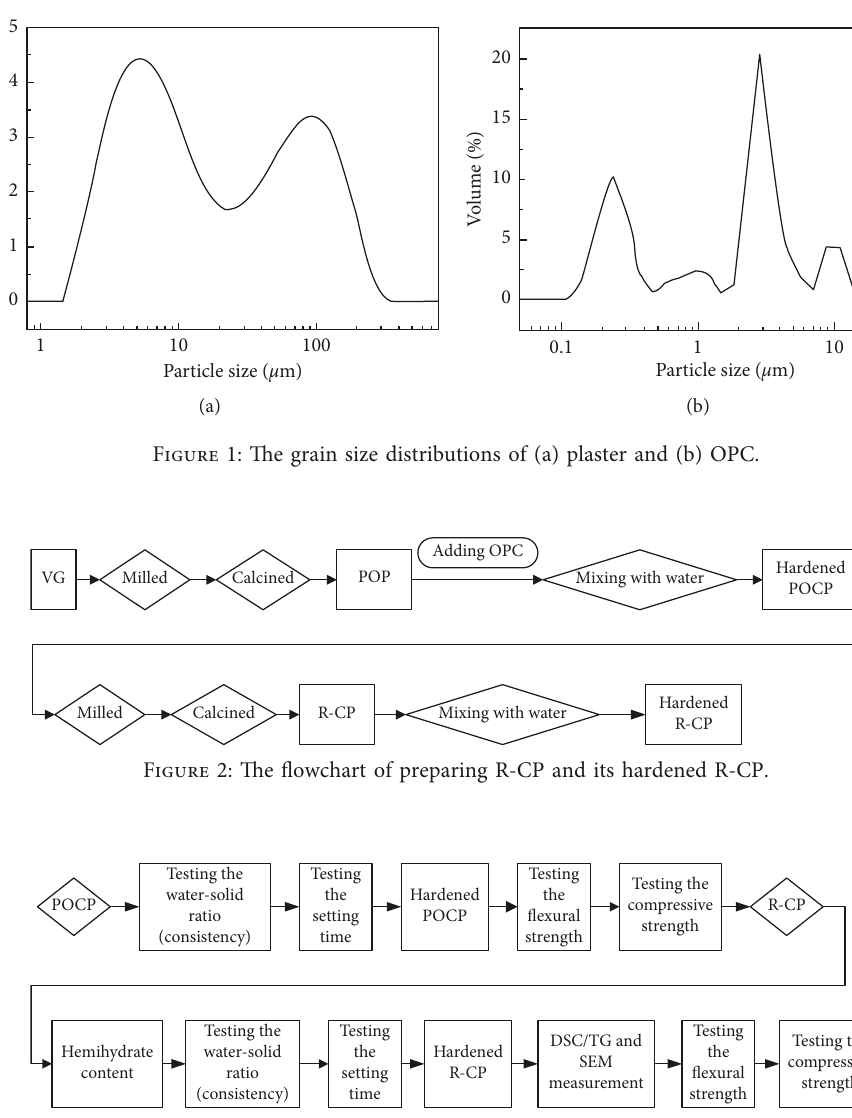
Figure 3: The testing